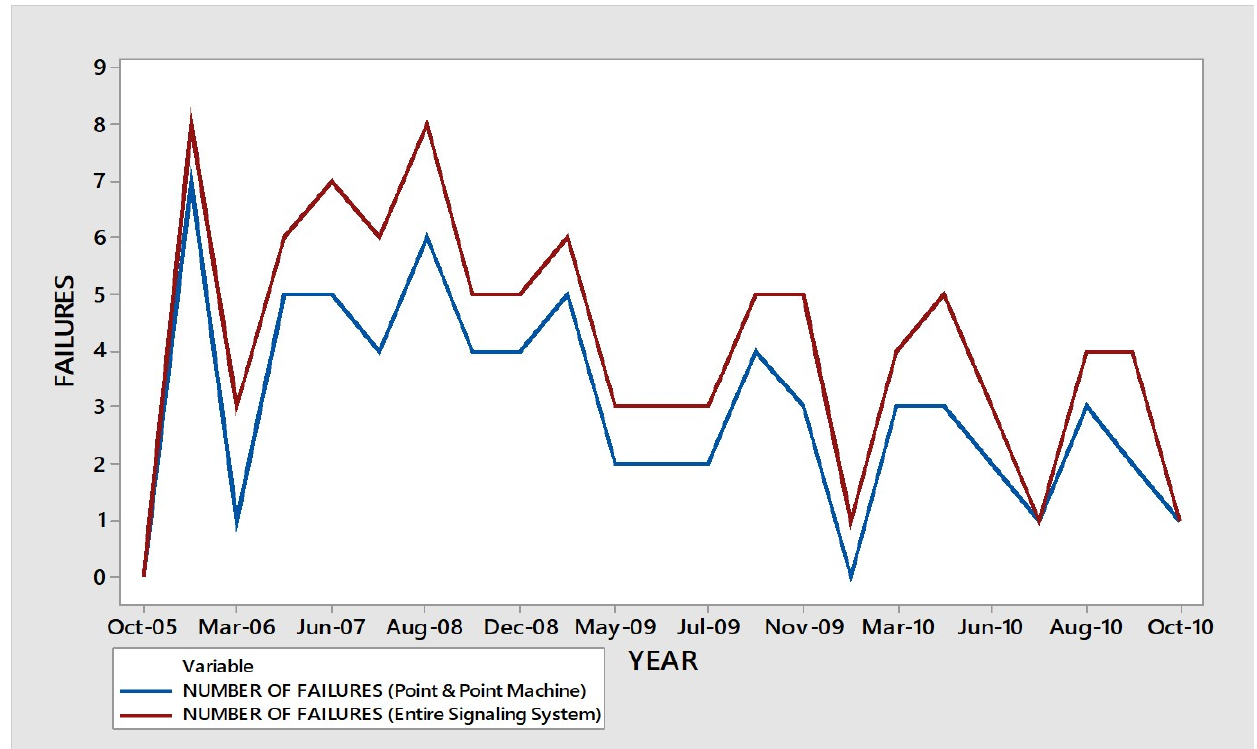
Figure 1. Comparison of failures of signalling subsystem and signalling